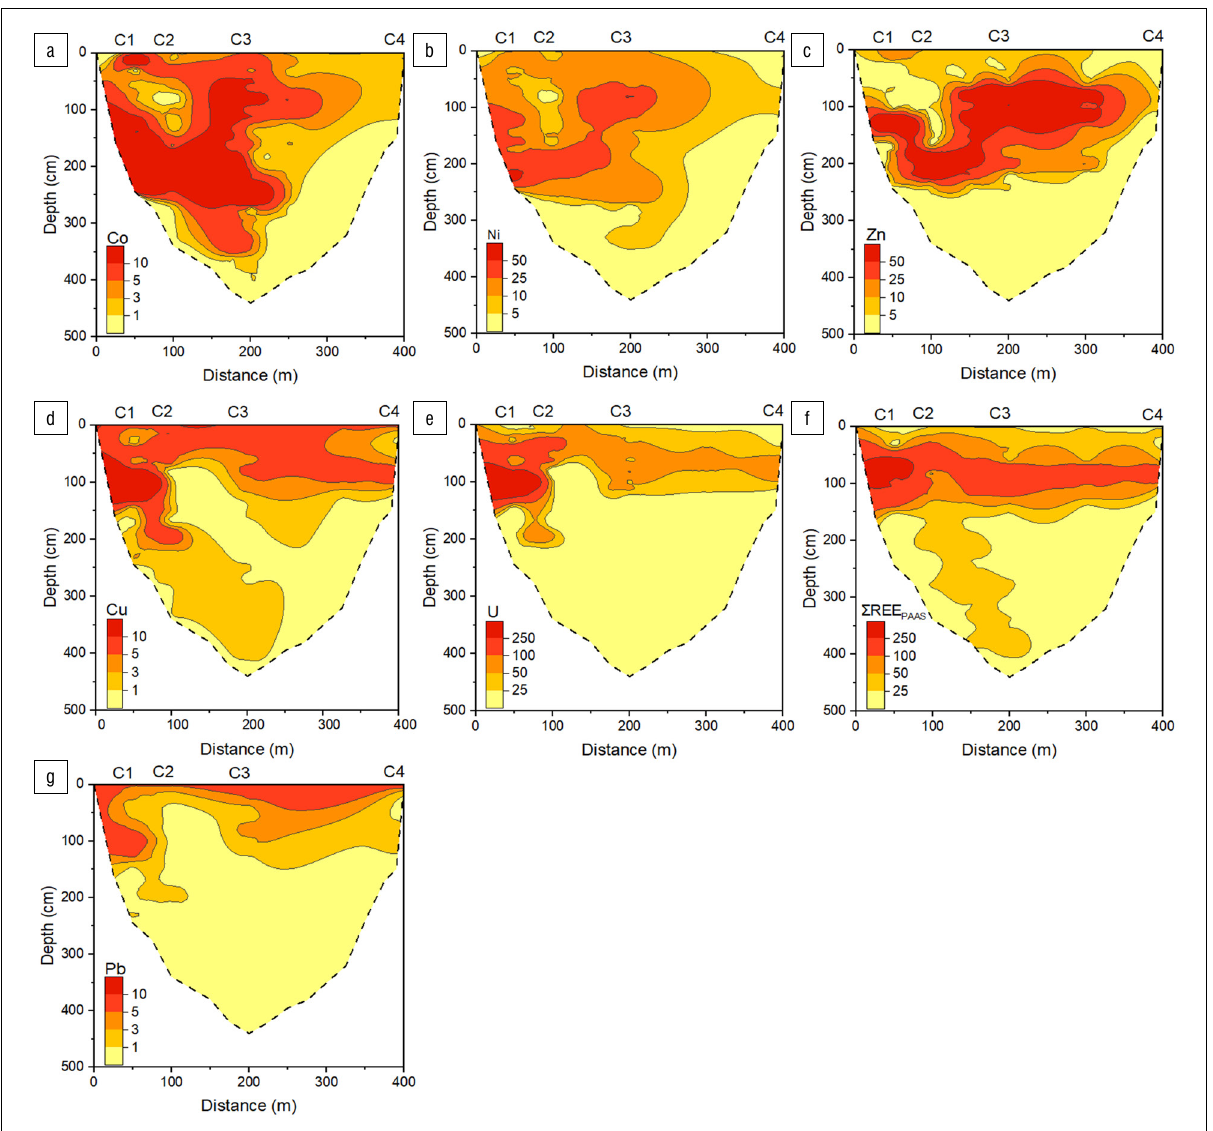
Figure 8: Contour maps illustrating the ingress of pollutants using the enrichment factors in the